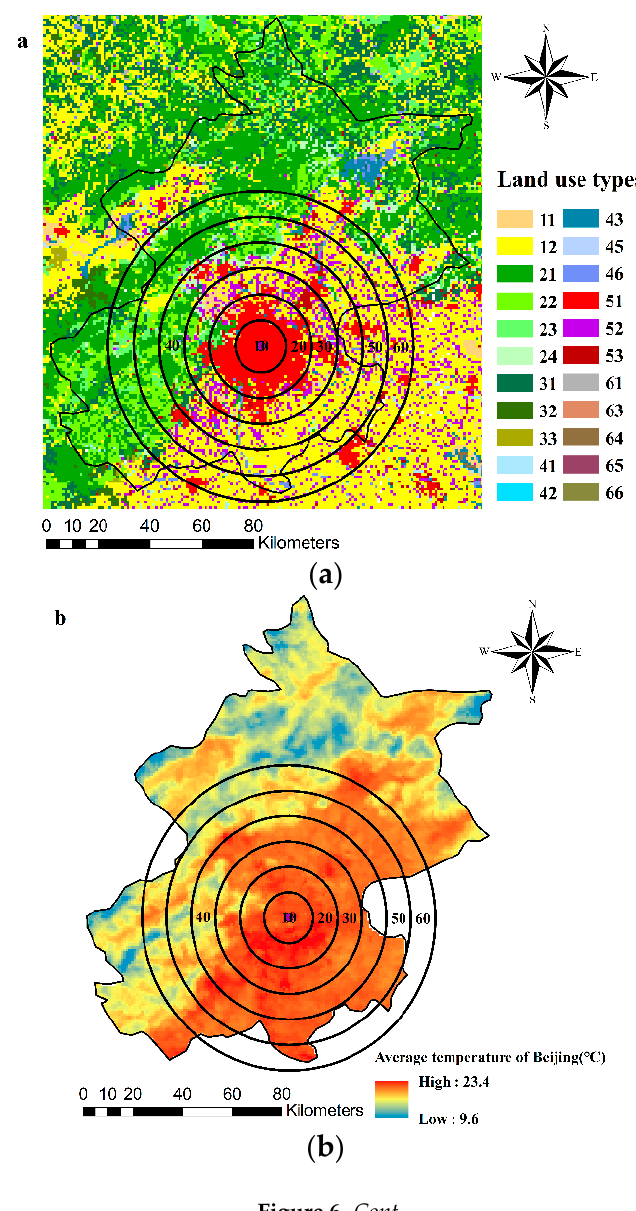
Figure 6b. According to the proportion of land-use type in di ff erent circles (Figure 6a), the x-axis of Figure 6c was defined as central areas within 20 km, expanded areas within 20–30 km, rural residential areas within 30–40 km, and suburbs within 40–60 km. Extending from central areas to suburbs, ◦ ◦ the mean surface temperature decreased from 21.72 C to 18.5 C, and there is an obvious di ff erence between the two areas. Central areas face a greater UHI e ff ect and the possibility of heatwaves occurring. The increased UHI e ff ect will bring more risks to social and economic losses with high population density and dense commercial activities in central areas, so that is the key area to promote the mitigation of the e ff ect. The UHI e ff ect in expanding areas is expected to be lower; however, a ff ected by population increase and urban construction, the temperature di ff erence between expanding and central areas gradually decreases, and it is important to prevent intensification of the heat island e ff ect in expanding areas. Suburbs usually have more vegetation coverage, which plays an important role in urban ecosystem maintenance and mitigation of the heat island e ff